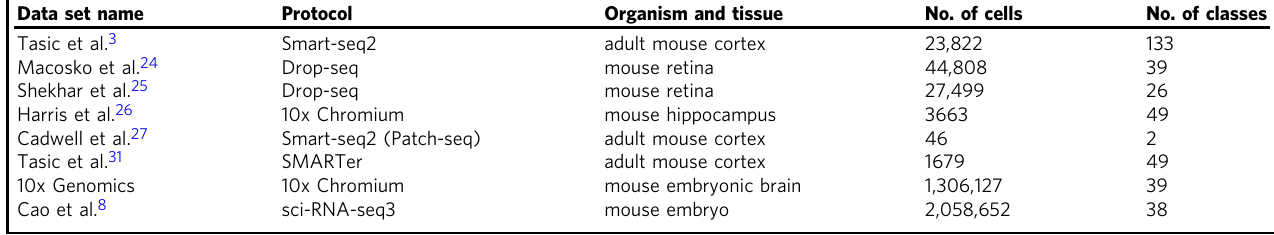
Table 1 Data sets used in this study, listed in the order of appearance in the text. In all cases, we relied on quality control and clustering performed in the original publications. For the 10x Genomics data set we used cluster labels from ref. 23